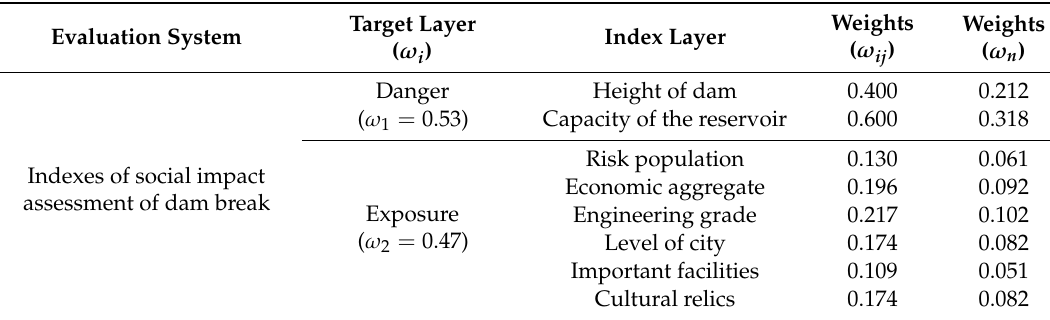
Table 4. Weights of each index in the evaluation system.